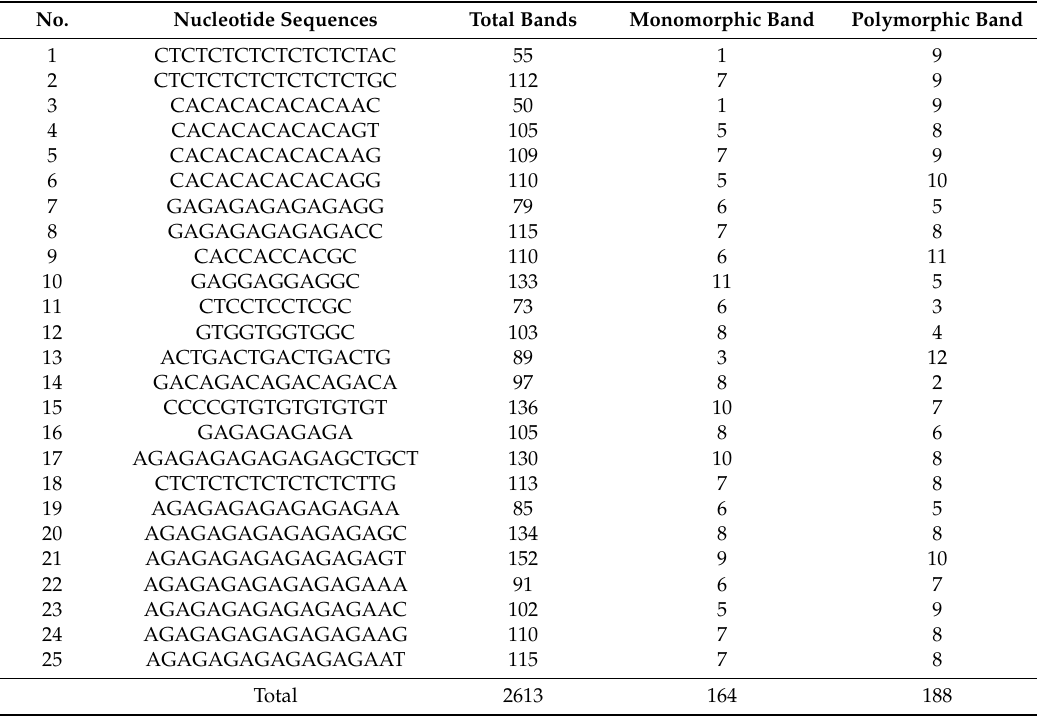
Table 2. The 25 successful primer sequences for inter-simple sequence repeats (ISSRs)-PCR markers. No.